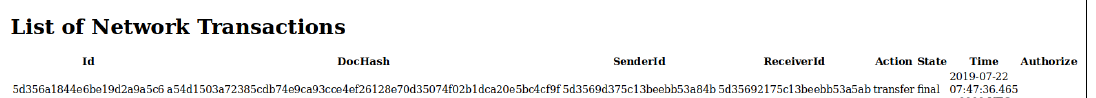
Figure 6. List of pending transactions in the network. This list is maintained by the index server.